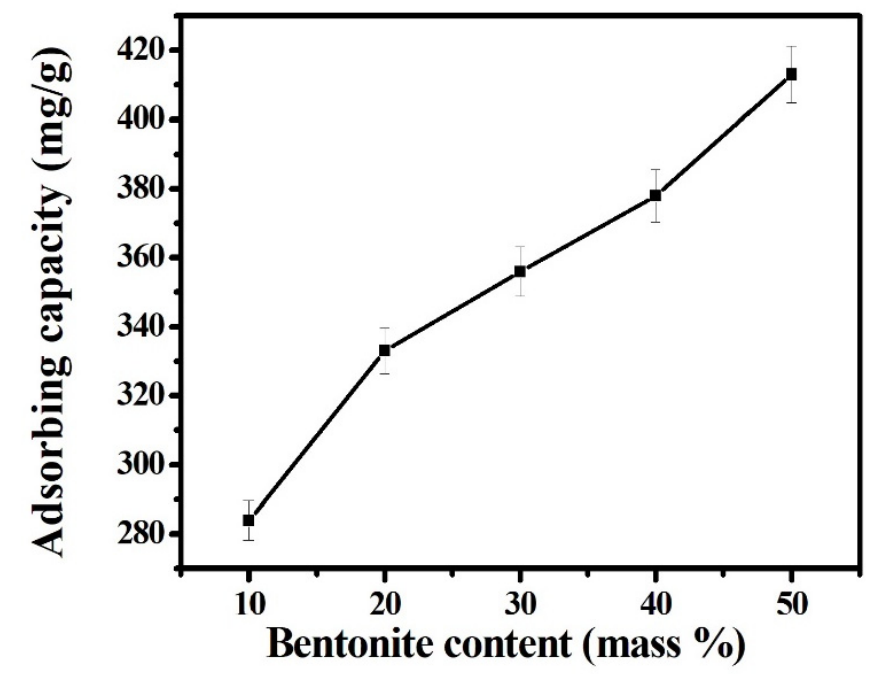
Figure 9. Effect of bentonite content on lysozyme adsorption.